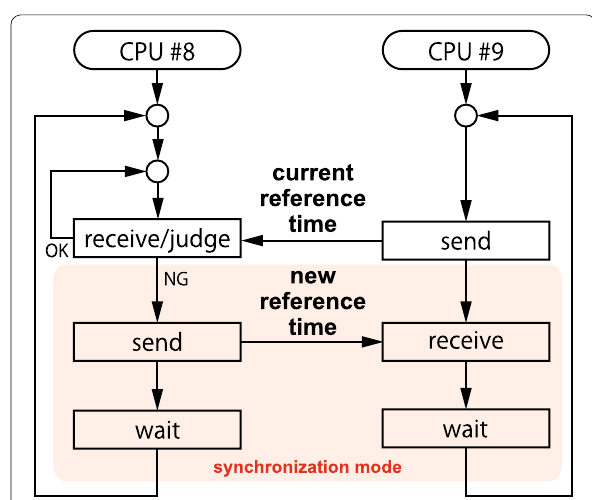
Fig. 4 A flowchart of the synchronized observation